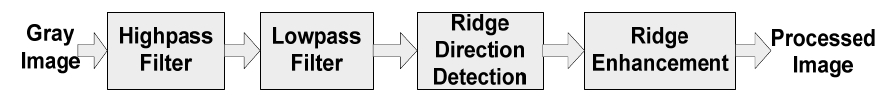
Figure 3. Image processing flow.